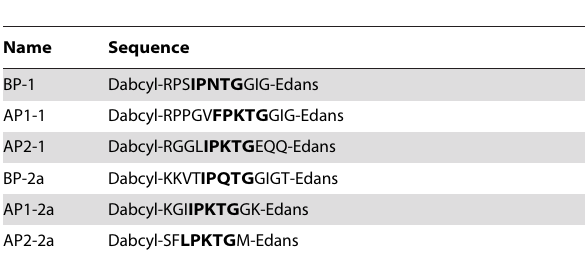
Table 2. Sequences of fluorescent peptides used in this